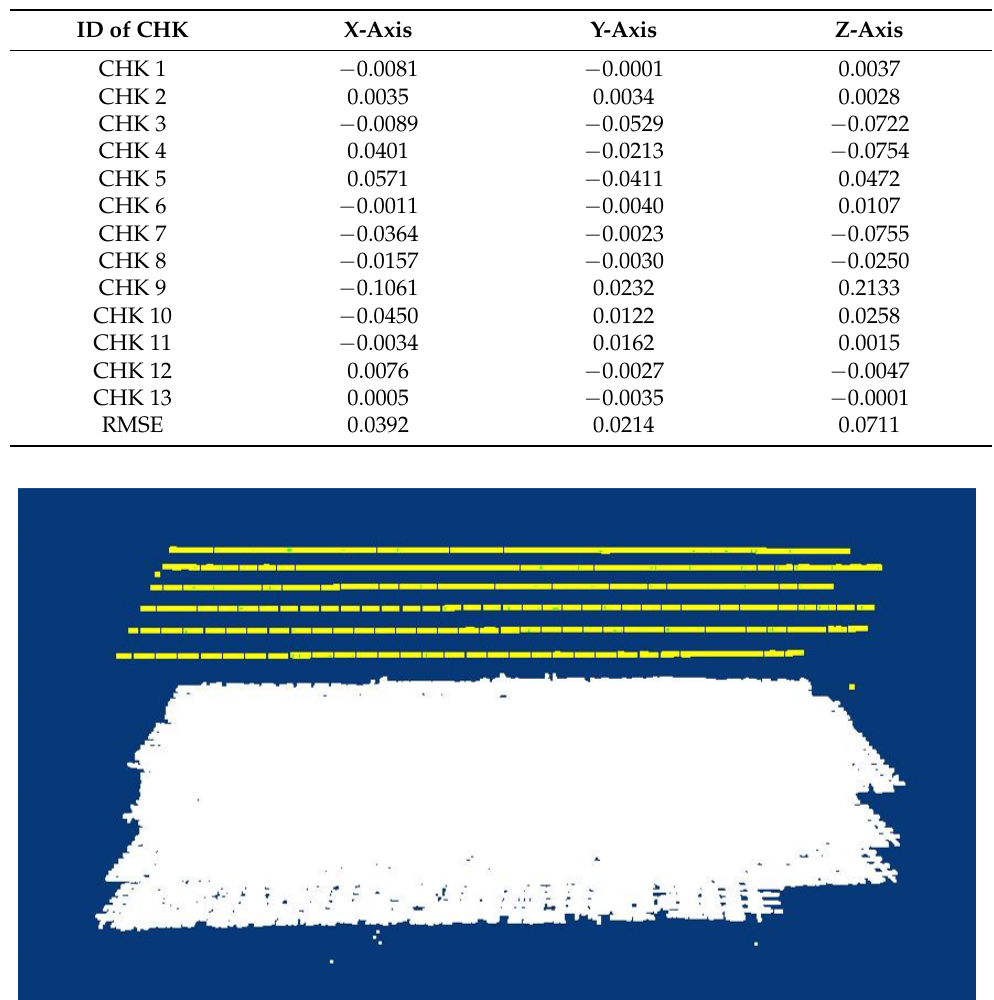
Table 4. Statistical Values for CHKS after the Third Experiment.